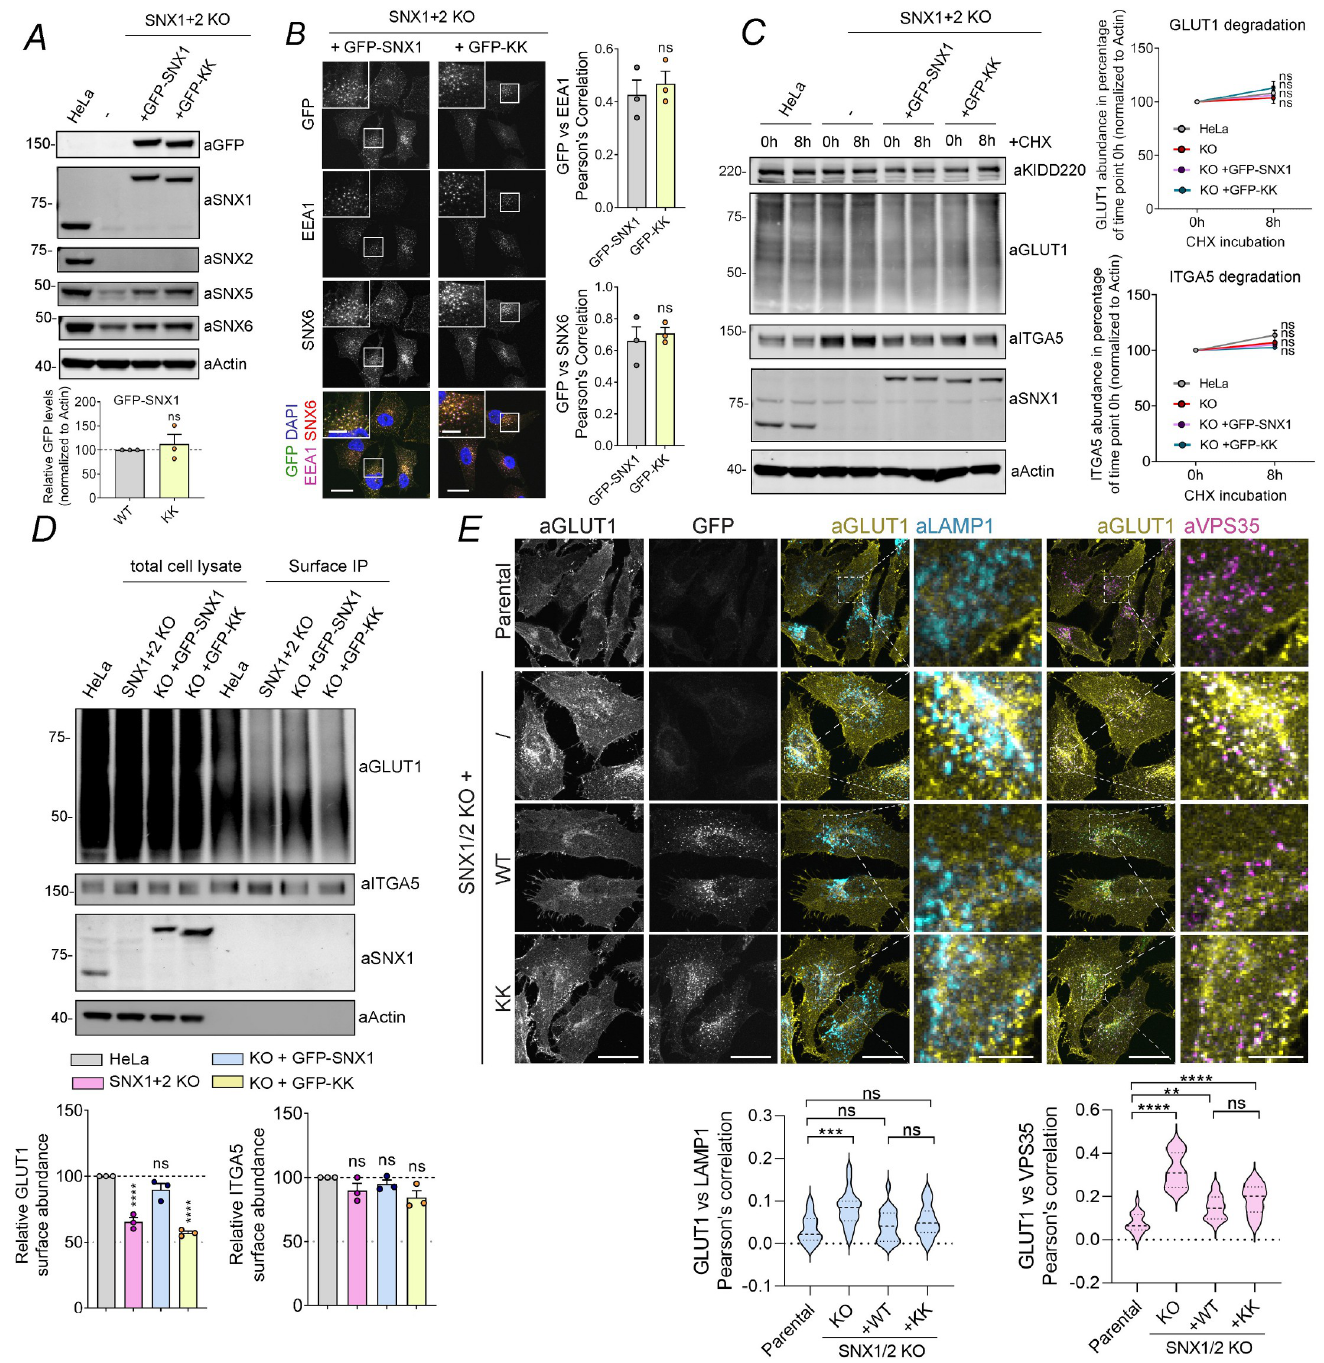
Fig 6. ESCPE-1 interaction with SNX27 is required for endosome-to-plasma membrane recycling of GLUT1. (A) Representative western blot showing similar expression levels between stably transfected GFP-SNX1 and GFP-SNX1(KK) in SNX1/2KO cells. SNX1 band intensities were measured from n = 3 and normalized to actin. Analysis was done using a 2-tailed unpaired t test. (B) Representative images of SNX1/2 KO HeLa cell line stably transfected with GFP-SNX1 or GFP-SNX1 (KK). Cells were fixed and immunostained for the endosomal markers EEA1 and SNX6. Magnified views of the white boxes are shown boxed. Cell numbers analyzed for colocalization were 50 GFP–SNX1 and 50 GFP–SNX1(KK) cells across n = 3 independent experiments. The Pearson coefficient values were compared using a 2-tailed unpaired t test; for EEA1 P = 0.5971, SNX6 P = 0.6459. (C) Degradation assay in parental HeLa cells or SNX1/2 KO HeLa cells that were stably transfected with GFP-SNX1 or GFP-SNX1(KK) mutant. Cells were incubated with 10 μ g/ml cycloheximide and lysed at different time points as indicated. The band intensities of endogenous GLUT1 and ITGA5 were measured from n = 3 independent experiments using Odyssey software. The levels of GLUT1 and ITGA5 at 8 hours were compared with the corresponding level at 0-hour time point. Analysis was done using a 2-way ANOVA and Sidak test. GLUT1: P = 0.6796